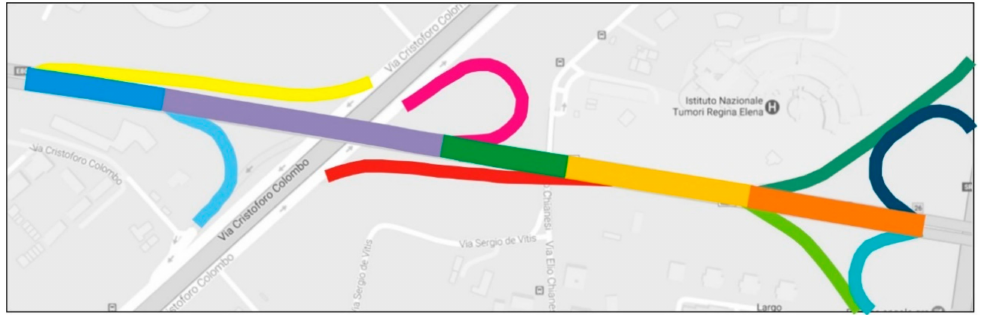
Figure 2. An example of elementary noise sources